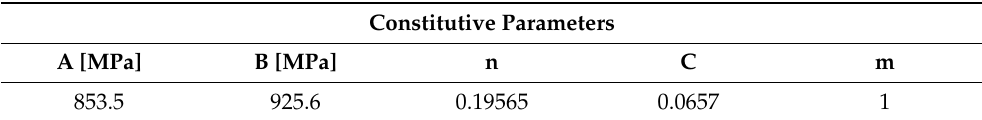
Table 4. Generalized values of the constitutive equation parameters.